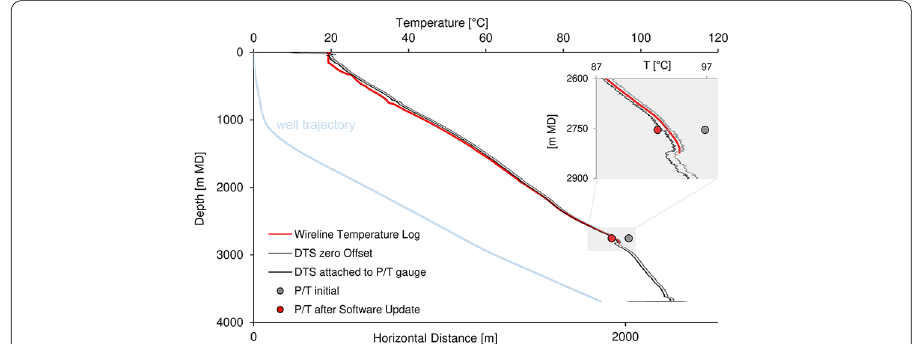
Fig. 3 Calibrated and non-calibrated DTS profiles of the Schäftlarnstraße site in comparison to P / T gauge data before and after software